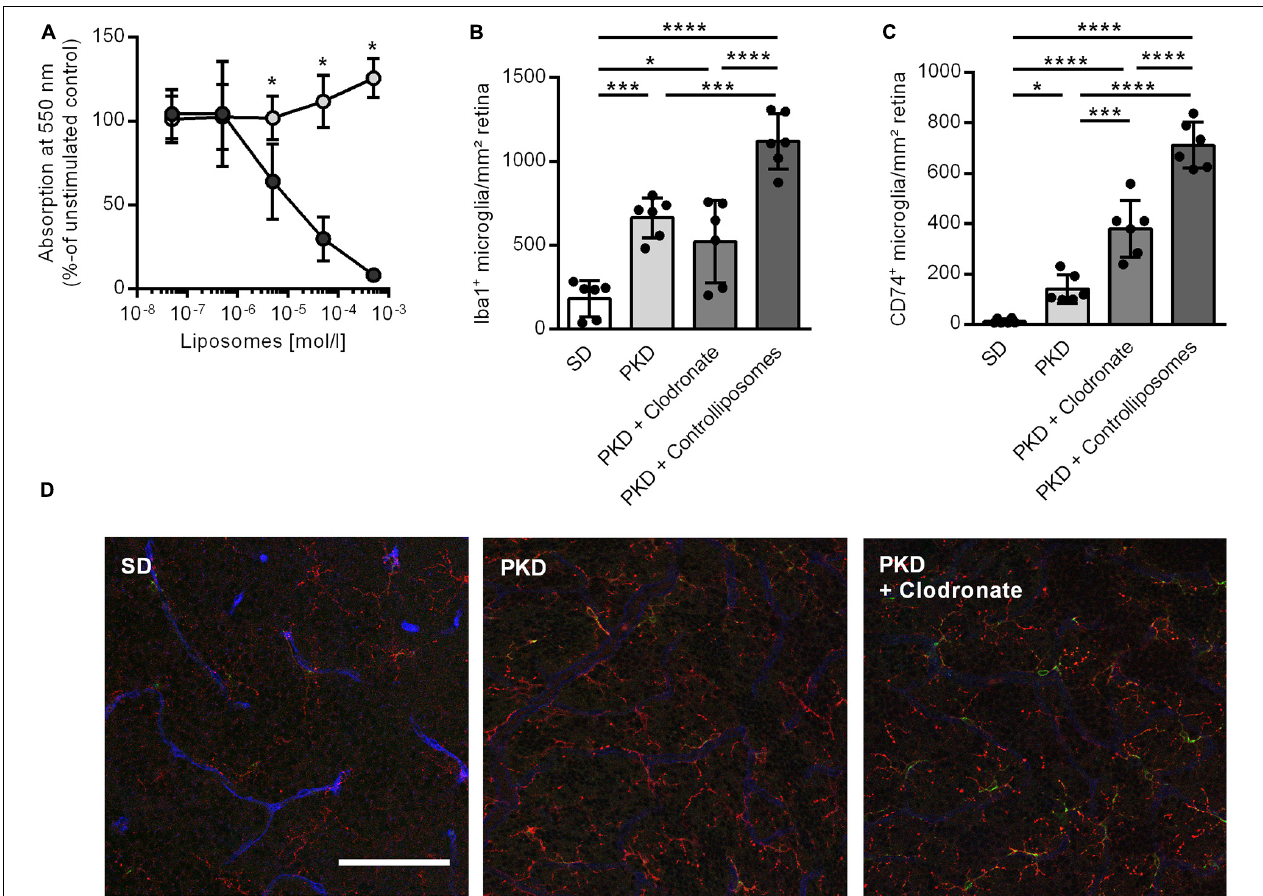
FIGURE 1 | Effects of liposomes on microglia in vitro and in vivo . (A) Clodronate liposomes (dark gray) lead to a concentration-dependent reduction in cell viability in BV2 microglia in vitro compared to control liposomes (light gray) in an MTT assay. * p < 0.05. (B–D) Clodronate liposome injection showed no effect on the total number of retinal microglia as assessed by Iba1 staining (B) but led to an increase in activated CD74 + microglia (C) . Injection of control liposomes increased both total (B) and CD74 + microglia (C) compared to controls as well as clodronate-treated animals. Representative images of the deep capillary network (D) in SD, PKD, and PKD + clodronate rats show the increase in Iba1 + (red) microglia in both PKD and PKD + clodronate rats, whereas the number of CD74 + (green) microglia is further increased in PKD + clodronate rats compared to PKD rats. Blue = lectin for endothelial staining. * p < 0.05, *** p < 0.001, **** p < 0.0001. Scale = 100 µ m.